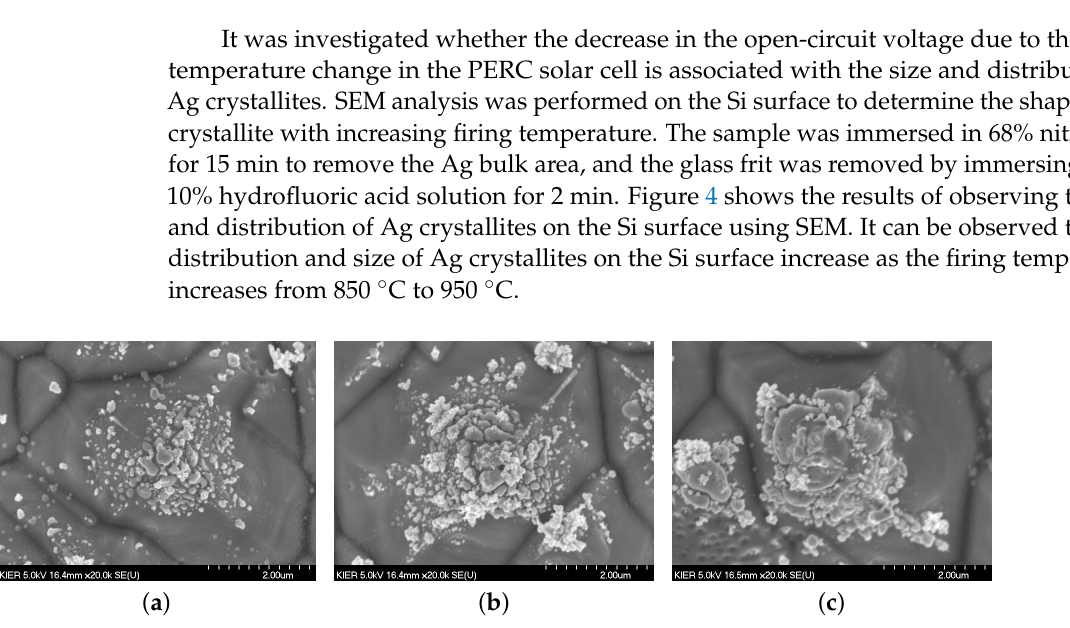
Figure 4. SEM images of Ag crystallite surface with the increase of temperature. ( a ) Firing temperature of 850 ◦ C, ( b ) firing temperature of 900 ◦ C, ( c ) firing temperature of 950 ◦